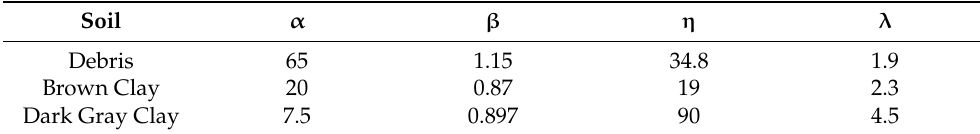
Table 4. Soil constants for Caronia